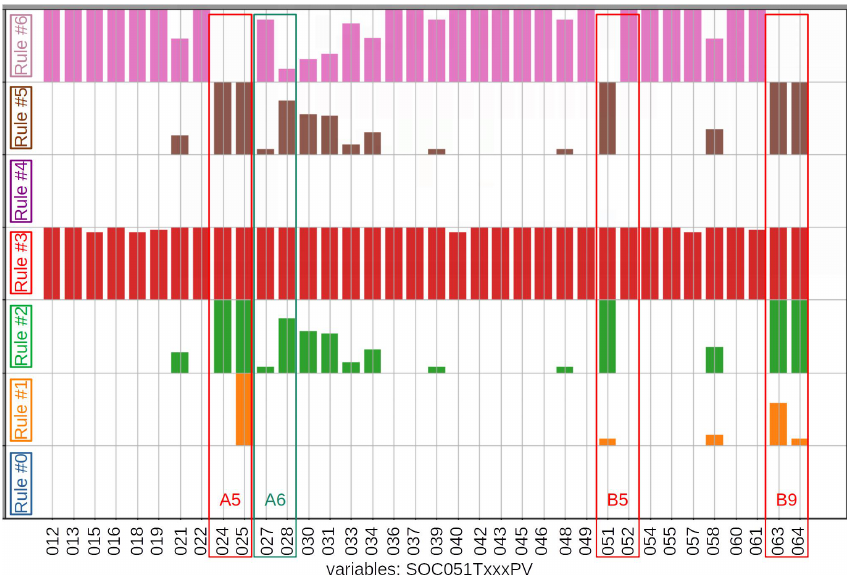
Figure 11. Bar graph of the cylinders subsystem during time window #2 (between 13:51 and 14:39). Within the same time window between 13:51 and 14:39, Figure 12 presents the bar graph of the exhaust gases subsystem. The bar graph indicates that rule #0 (blue) was activated for variable SNA051T049PV (temperature sensor for cylinder B7), indicating operation outside three deviation limits. It can also be observed that, concerning variables SNA051T031PV (temperature sensor for cylinder A7) and SNA051T037PV (temperature sensor for cylinder B1), rule #1 (orange) was activated while rule #6 (pink) was not activated, indicating that these cylinders (especially A7) might have shown a trend towards